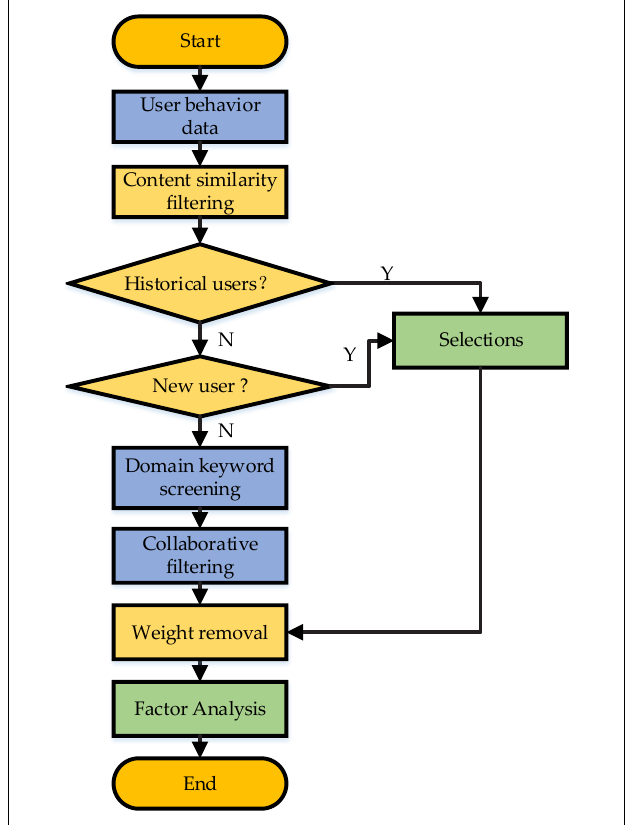
FIGURE 2 | Recommended flowchart of hybrid